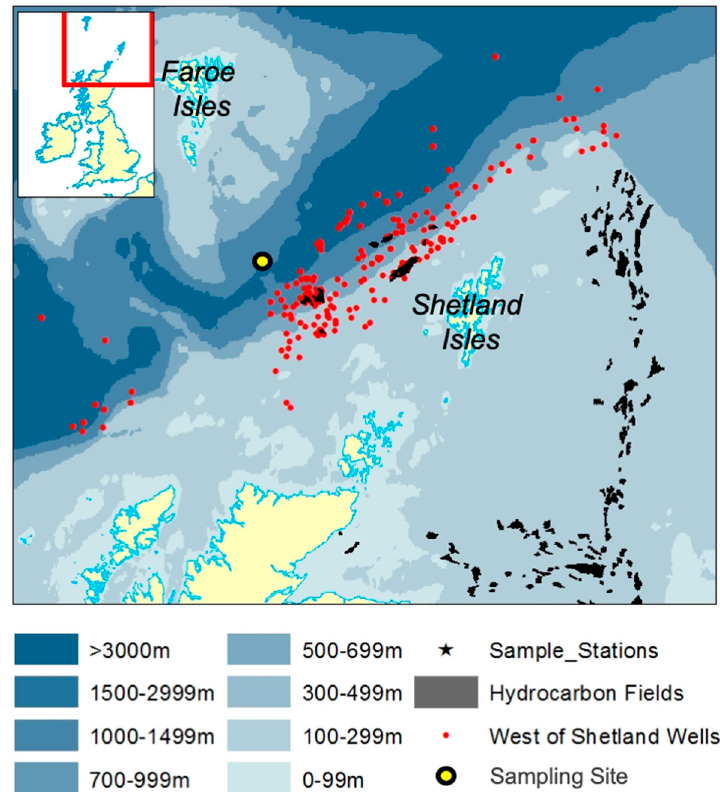
Figure 1. Map representing the Faroe-Shetland Channel showing bathymetry contours, hydrocarbon gas/oil wells and production fields, and the sampling location.